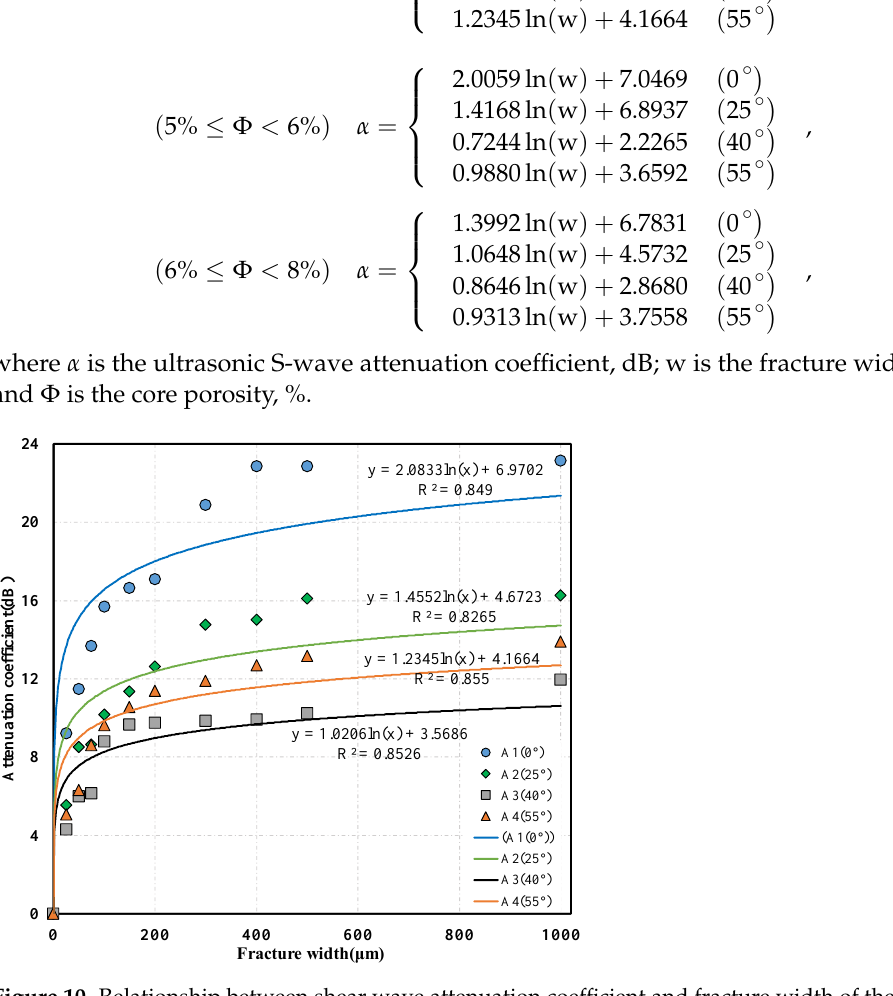
Figure 11. Relationship between shear wave attenuation coefficient and fracture width of the set of B cores containing fractures with different dip angles.